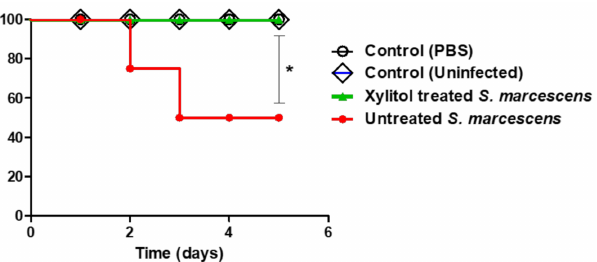
Figure 7. Xylitol protected mice against death by S. marcescens . Four mouse groups of healthy mice comprising five mice each were used. In group 1, mice were intraperitoneally injected with xylitol- treated S. marcescens in sterile PBS, group 2 was injected with untreated bacteria, group 3 was injected with sterile PBS and group 4 was left un-inoculated. Mouse survival in each group was recorded every day over 5 days, plotted using the Kaplan–Meier method, and significance ( p < 0.05) was calculated using the Log-rank test, GraphPad Prism 5. All mice in groups 3 and 4 (negative control groups) survived, while only 60% of mice survived (three out of five mice) in the group of the untreated bacteria. In contrast to untreated S. marcescens , all mice injected with xylitol-treated S. marcescens survived, showing 100% survival, conferring 40% protection (Log rank test for trend * p = 0.02).